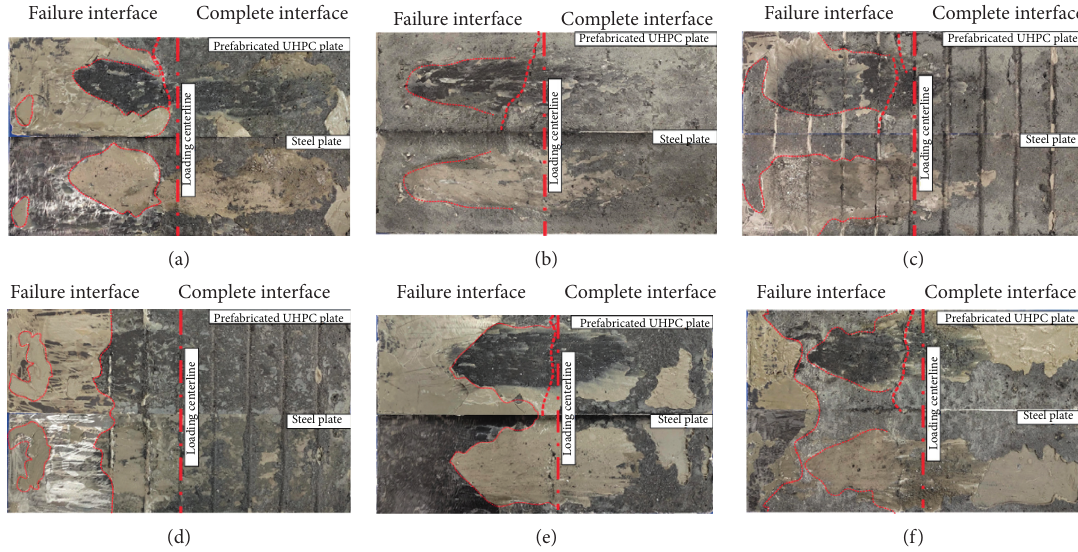
Figure 9: Failure interfaces of specimens. (a) CD-ER-P- λ λ 4.44. (f) CD-ERA-P- λ